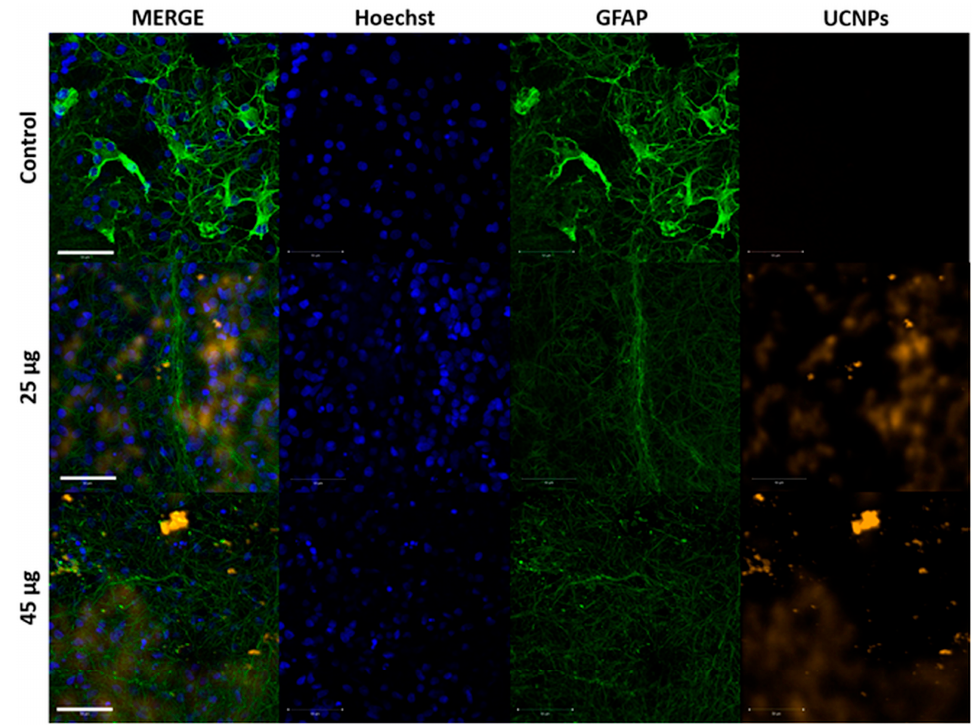
Figure 6. Confocal images of the OHSCs incubated for 2 h with 25 μ g and 45 μ g of UCNPs applied as droplets on the OHSCs surface. UCNPs were excited with a 980 nm femtosecond laser (orange color), astrocytes (GFAP) were excited with a 488 nm argon laser (green color), and cell nuclei were stained with Hoechst 33342 dye and excited with a 690 nm femtosecond laser (blue color). The presented MERGE image is a composite of all channel images. Controls were OHSCs without UCNPs. Scale bar—50 μ m.